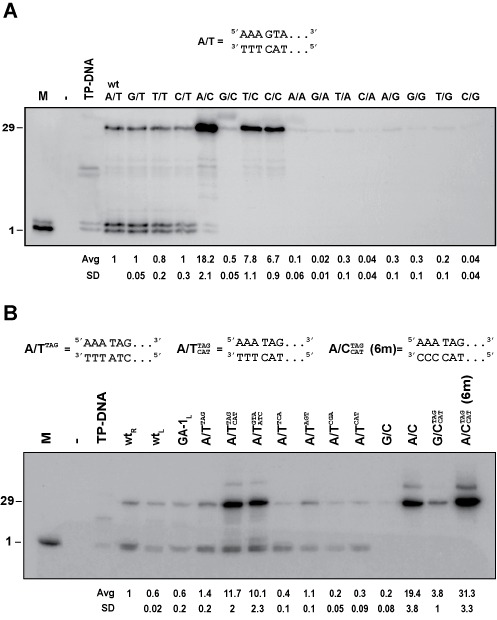
(A) Effect of group substitution of the first three nucleotides at the template and displaced strands on replication origin utilization. Double-stranded DNA origins were assembled with synthetic oligonucleotides to generate the different end combinations. Reactions were performed as described in Materials and Methods using [α32P] dATP as labeling nucleotide, and the reaction products were analyzed by high-resolution SDS-PAGE with 12% acrylamide. The positions corresponding to TP-dAMP (1) and full length product (TP-29 nucleotides ssDNA) are indicated. M, initiation reaction marker (reaction using TP-DNA as template and dATP as the only nucleotide, see Materials and Methods section); TP-DNA, control reaction with TP-containing Φ29 genome as template (this reaction produces the initiation and partial elongation bands [+15,+16] in addition to full-length Φ29 DNA [not shown]). The different pairs of oligonucleotides hybridized to generate the artificial origins are noted as follows (see scheme above Figure 1): the first letter stands for the first three nucleotides of the displaced strand and the second letter stands for the first three nucleotides of the template strand (for example, A/T denotes an origin with the paired sequence at the end AAA/TTT). The rest of the origin is the sequence of the Φ29 DNA right end from positions 4–29 (see Materials and Methods section). For example, the wt origin is the A/T combination. At the bottom of the figure are shown the mean values of the quantification of the intensities of the bands corresponding to full length products compared to the wt (wt = 1), with their corresponding standard deviations. Values are the average of at least three independent experiments. (B) Effect of nucleotide substitutions at positions 4–6 and unpairings on replication origin utilization. As previously, double-stranded DNAs were assembled with synthetic oligonucleotides to generate the different combinations. Reactions were analyzed by 12% SDS-PAGE. The positions corresponding to TP-dAMP (1) and full length product (TP-29 nucleotides ssDNA) are indicated. wtR, Φ29 DNA right origin of replication (29 bp); wtL, Φ29 DNA left origin of replication (29 bp), GA-1L, GA-1 left origin of replication (29 bp); as in Figure 1, two capital letters indicate the first three nucleotides of the displaced strand and the first three nucleotides of the template strand, respectively; in addition to that, superindexes alone (A/TNNN) denote the sequences from positions 4–6 of the displaced strand if other than wt and paired. Superindexes and subindexes (\documentclass[12pt]{minimal}
\usepackage{amsmath}
\usepackage{wasysym} 
\usepackage{amsfonts} 
\usepackage{amssymb} 
\usepackage{amsbsy}
\usepackage{upgreek}
\usepackage{mathrsfs}
\setlength{\oddsidemargin}{-69pt}
\begin{document}
}{}${\rm A/T}_{{\rm CAT}}^{{\rm TAG}}$\end{document}) denote the sequences from positions 4–6 of the displaced and template strands, respectively, when they are unpaired (see scheme above Figure 1B).